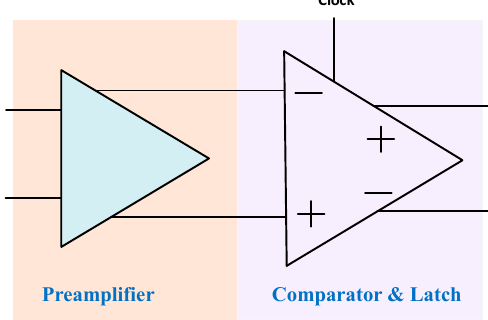
Figure 15. Block diagram of a single-bit quantizer.